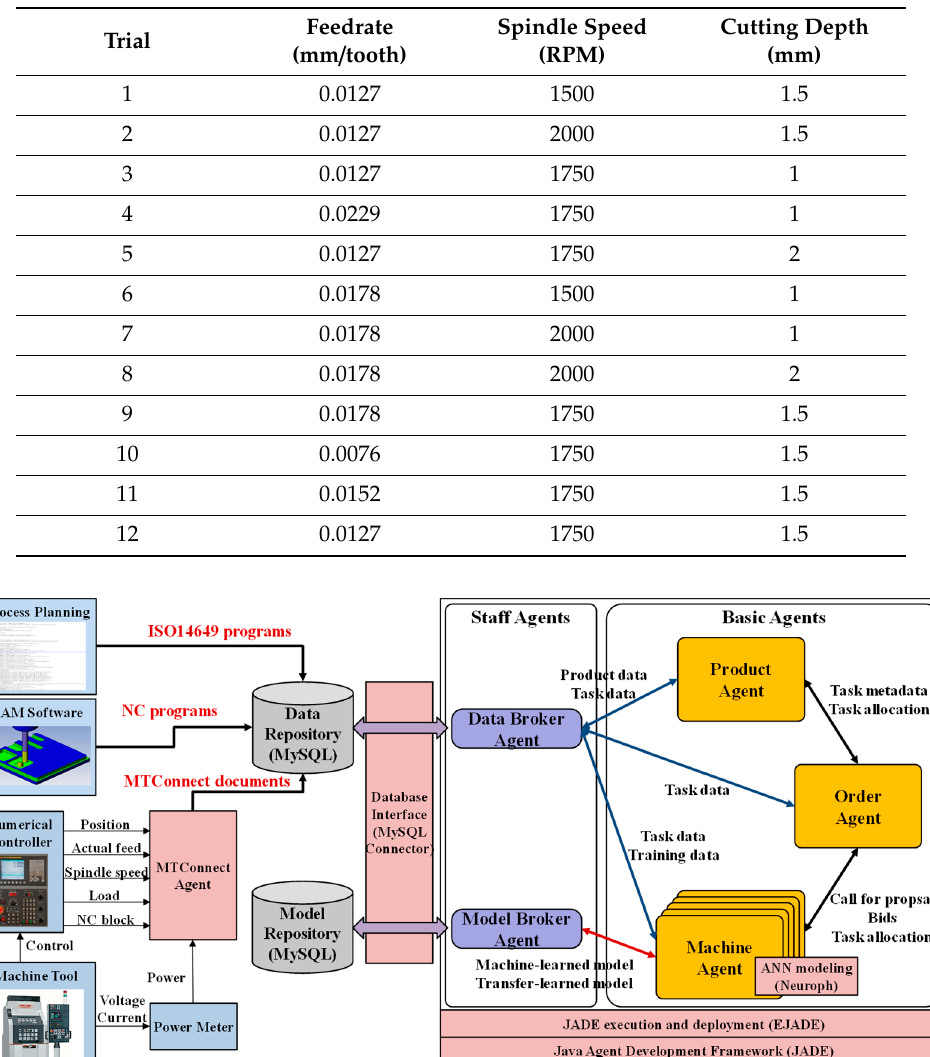
Table 4. List of process parameters.